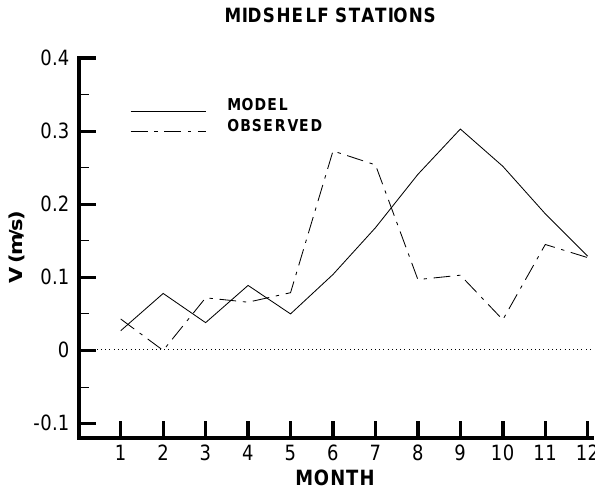
Fig. 15. As in Fig. 8 except for the mid-shelf stations (current meter depth 30m; water depth